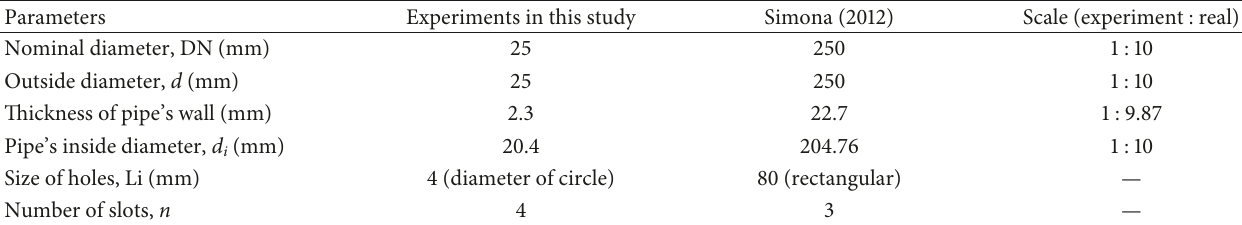
Table 1: Proposed partial drainage pipes’ configuration.